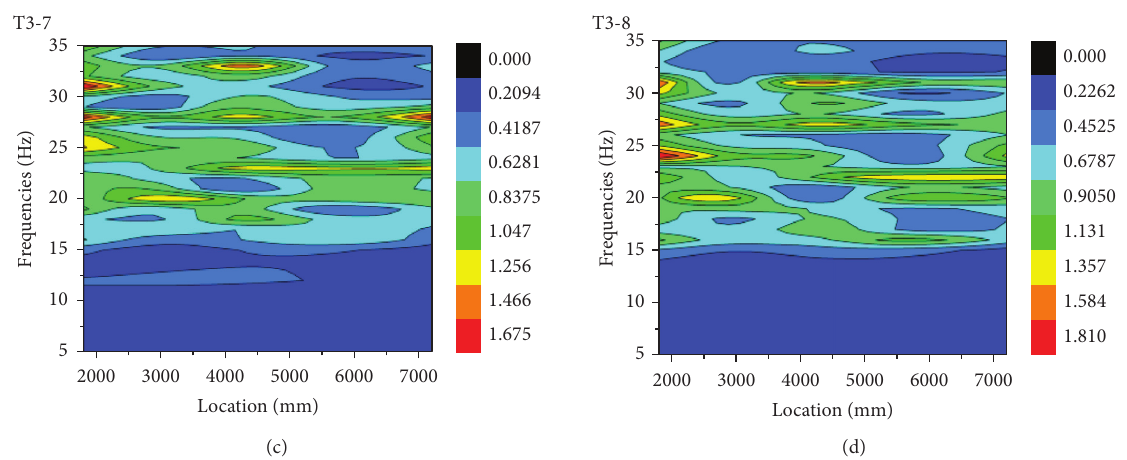
Figure 14: Transfer functions of the T3 test floors with the 600 mm joist